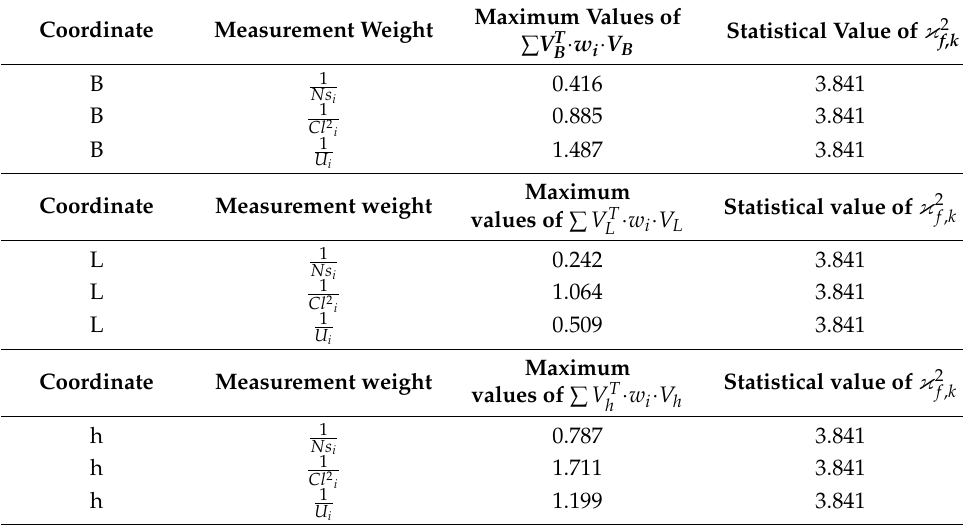
Table 5. The results of the global Chi-square